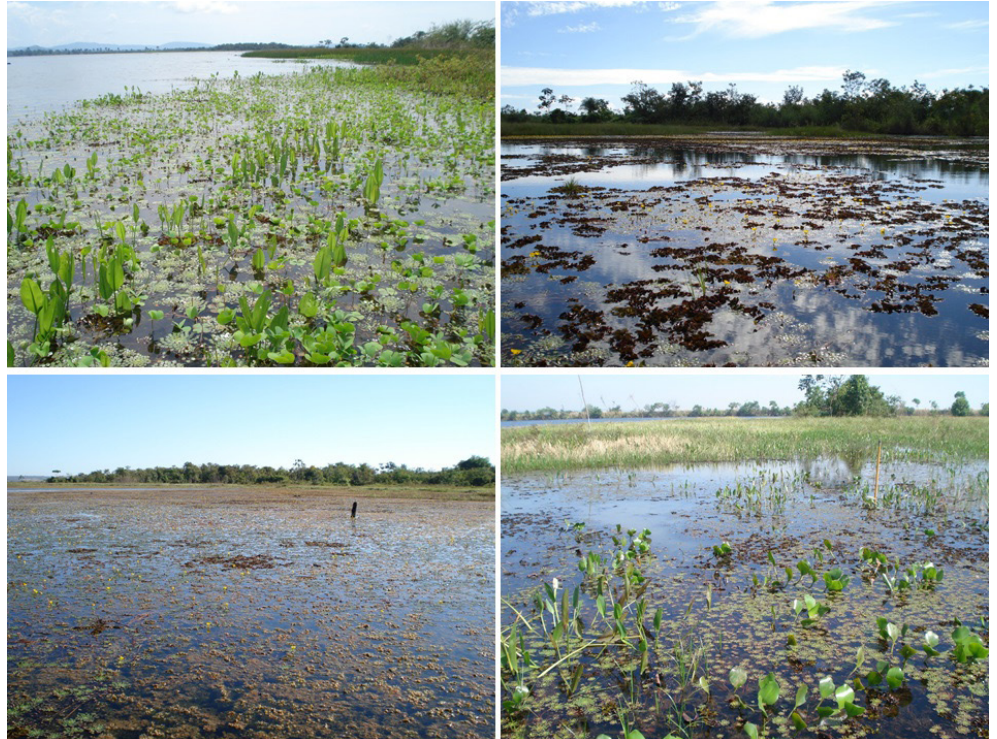
Figure 2. Shallow habitats in the Lajeado Reservoir, Tocantins River, where aquatic macrophytes have developed extensive multi-specific stands along the littoral